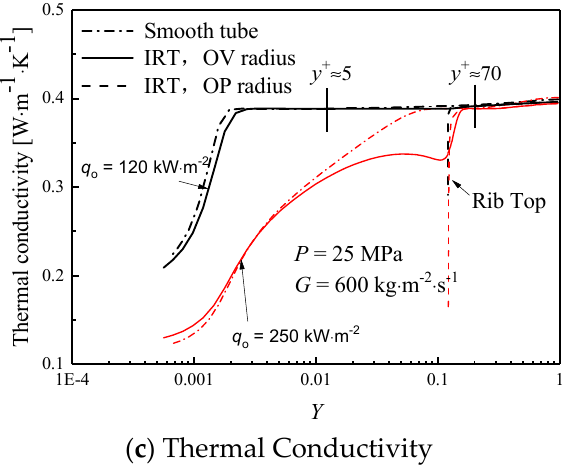
Figure 10. Comparison of the thermophysical properties distribution of supercritical water in IRT and ST.